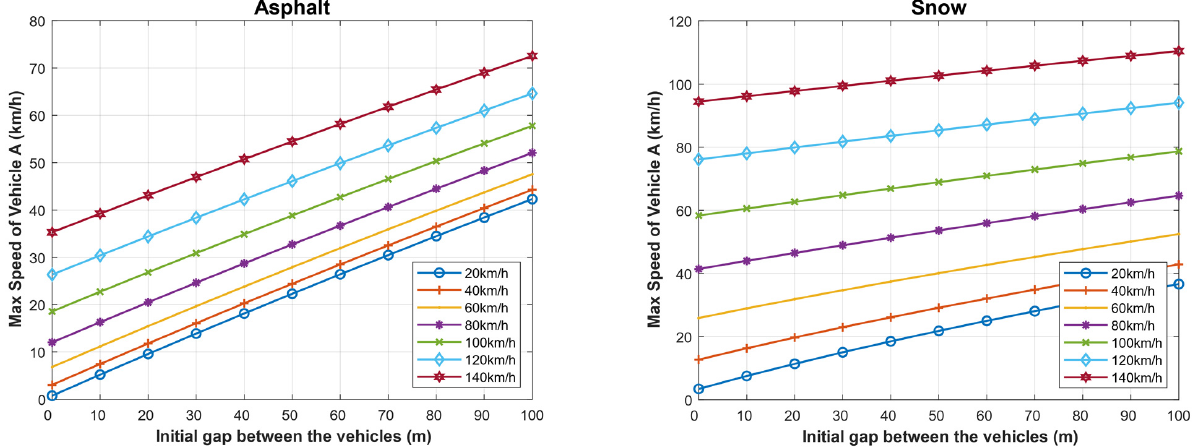
Figure 15. In foggy weather: maximum speed of the following vehicle for different speeds of the followed vehicle for different initial distances between the two vehicles when the driver reaction ( 𝑇 (cid:3045)(cid:3002) = 8 s ) .